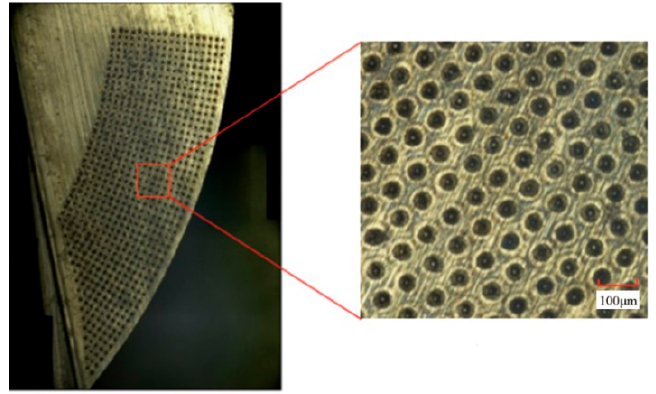
Figure 8. Texture profile of micro-circular pits.